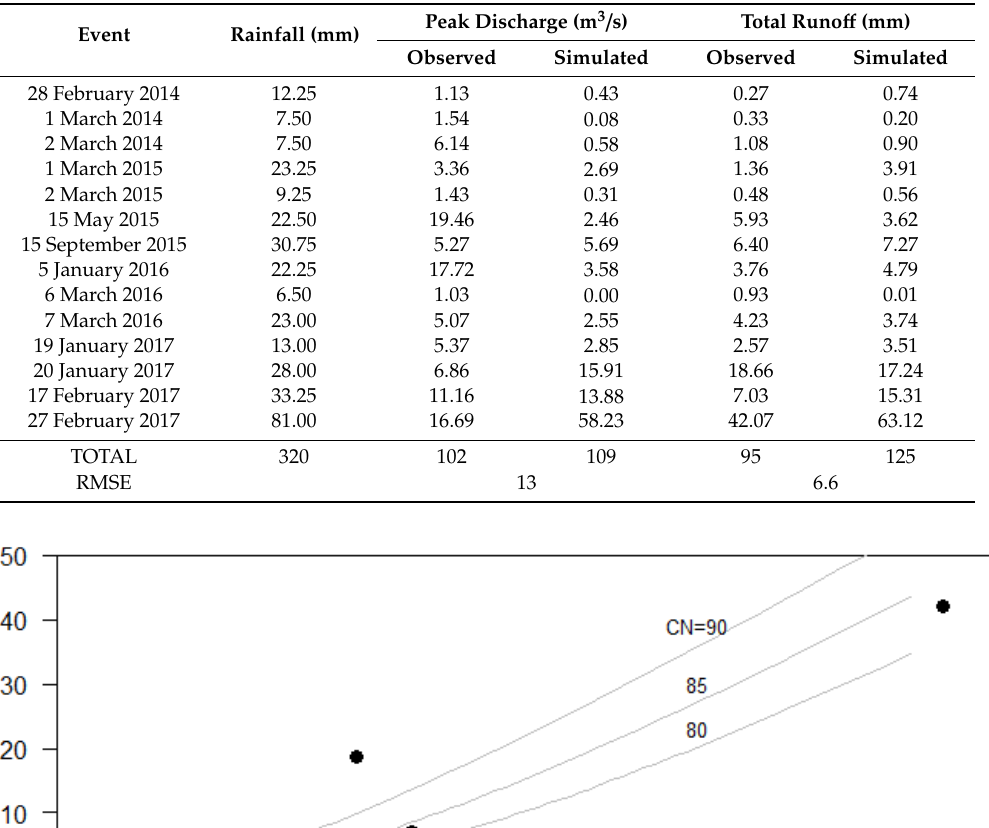
Table 5. Summary of storm events used for model calibration.